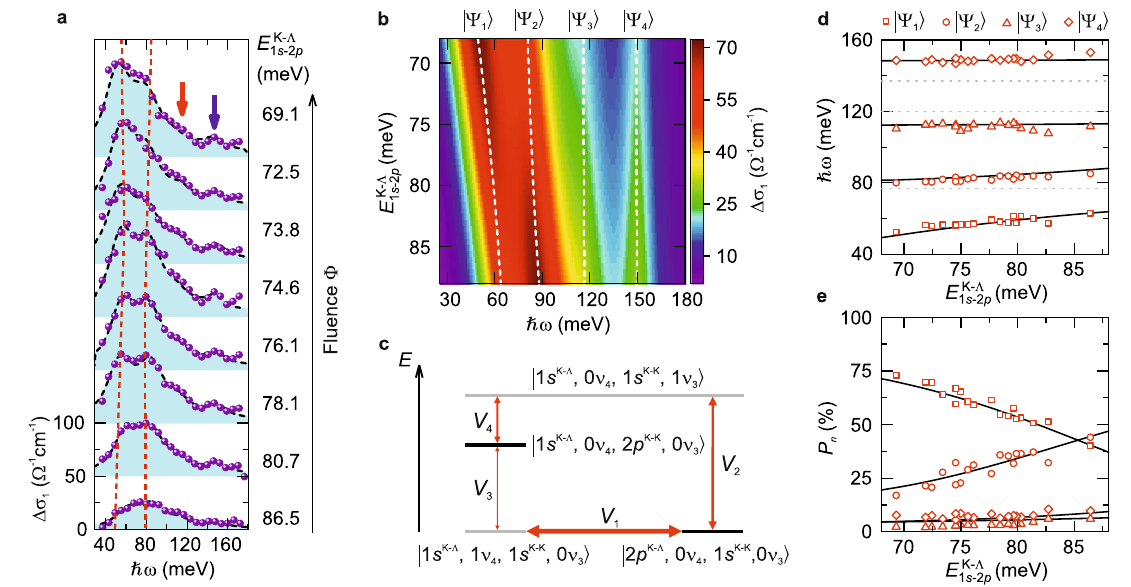
Fig. 3 Anticrossing in interlayer exciton – phonon quantum hybridization. a Experimentally observed pump-induced changes of Δ σ 1 ( t pp = 3 ps, T = 260 K) of a 3R-stacked WSe 2 bilayer covered with few-layer gypsum, for different excitation fl uences Φ indicated on the right. When Φ is increased from 5 to 36 µ J cm − 2 (from bottom to top), many-body renormalization shifts the intra-excitonic resonance E K (cid:1) Λ from above to below the ν 4 phonon resonance, (cid:3) (cid:3) (cid:4) (cid:4) 1 s (cid:1) 2 p (cid:3) (cid:3) unveiling exciton – phonon anticrossing. The red dashed lines are guides to the eyes for the peak position of Ψ 1 and Ψ 2 . The excellent agreement con fi rms the interlayer exciton – phonon between theoretical simulation (black dashed lines) and experimental data (solid spheres) across all E K (cid:1) Λ 1 s (cid:1) 2 p hybridization. b Two-dimensional plot of the simulated Δ σ 1 spectra based on the Hamiltonian shown in Eq. (1) as a function of E K (cid:1) Λ . The color scale, 1 s (cid:1) 2 p vertical axis, and horizontal axis represent Δ σ , E K (cid:1) Λ , and the probe photon energy, respectively. Dashed white lines indicate the energies of Lyman (cid:3) (cid:4) 1 1 s (cid:1) 2 p (cid:3) polaron eigenstates ( Ψ n , n = 1, 2, 3, 4). c Illustration of the effective coupling between different excitonic states (black lines) and phonon states (gray (cid:3) (cid:3) (cid:4) (cid:3) (cid:3) ; 1 s K (cid:1) K ; 0 ν ; 1 s K (cid:1) K ; 0 ν state 1 s K (cid:1) Λ ; 1 ν lines). When the zero-phonon 1 s – 2 p transition energy of the K – Λ exciton state 2 p K (cid:1) Λ ; 0 ν is tuned across the ν 4 3 4 4 3 (denoted by the thick red arrow) anticrossing occurs. d , e Solid lines show the calculated energies of the Lyman polaron eigenstates ( d ) and projection ( P n ) (cid:3) (cid:3) ; 1 s K (cid:1) K ; 0 ν of the eigenstates to the bare 2 p K (cid:1) Λ ; 0 ν 4 3 to the measured Δ σ 1